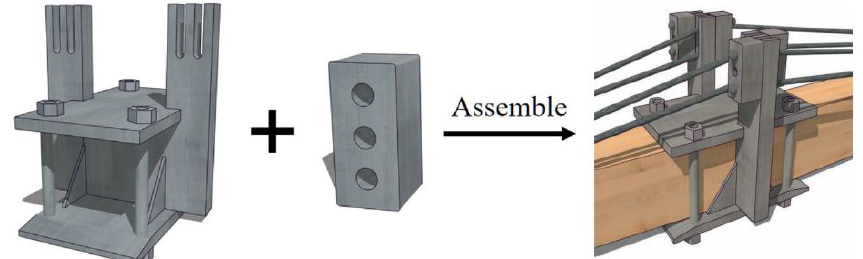
Figure 1. The connection device diagram.